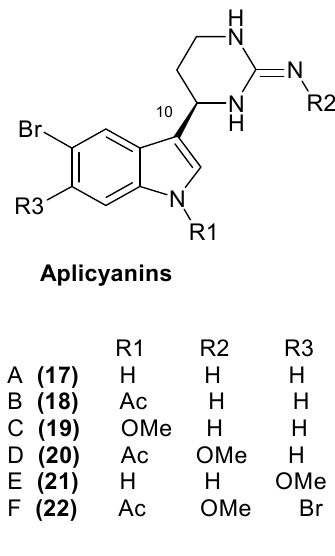
Figure 5. Aplicyanin structures isolated from the tunicate Aplidium cyaneum